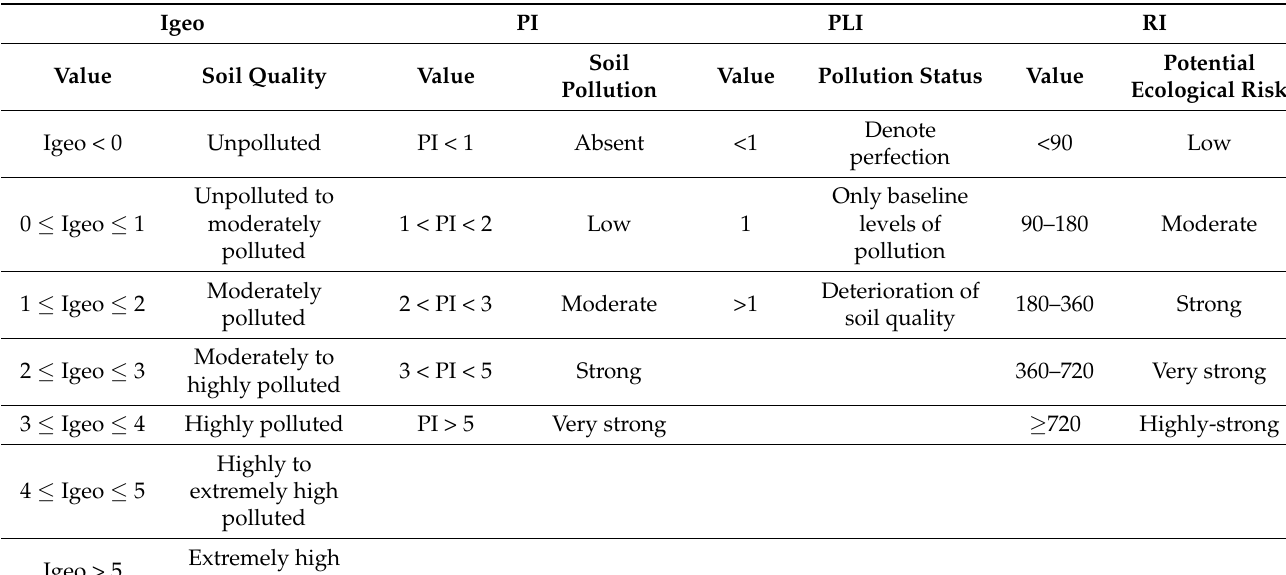
Table 2. Evaluation scales of used indexes